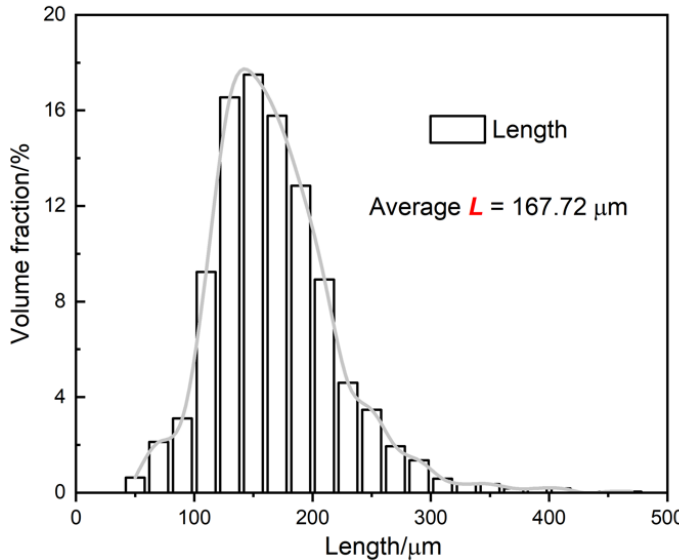
Figure 3. Volume-based distribution histogram for the length, L .